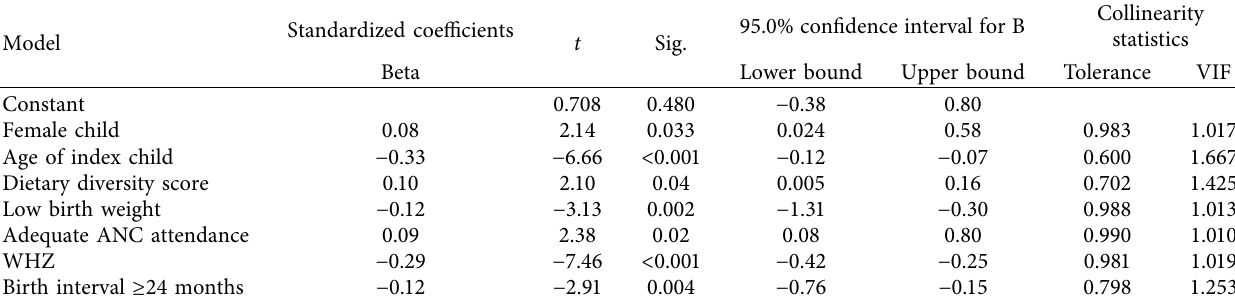
Table 3: Predictors of the length-for-age z -score (multivariable regression analysis).